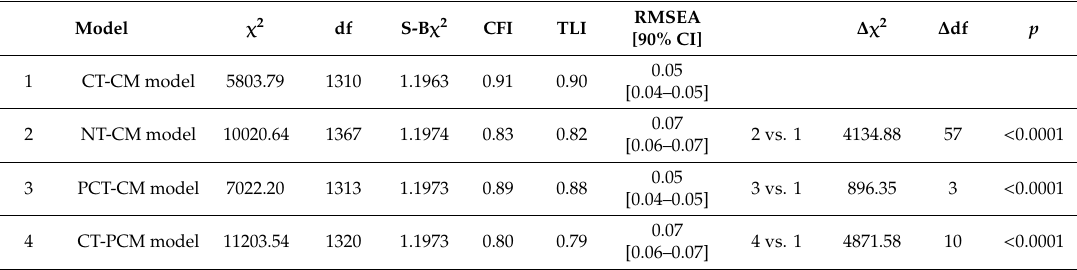
Table 2. Model fit indices for the Multi-Trait, Multi-Method framework of the